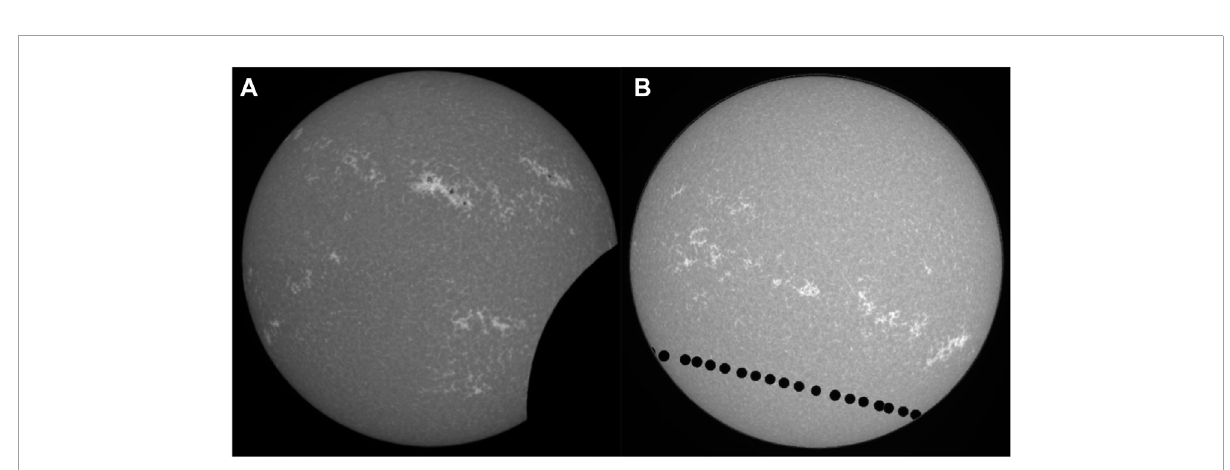
FIGURE 4 Examples of the solar observations obtained with the Rome/PSPT at the Ca II K line during the partial solar eclipse on 11th August 1999 (A) and transit of Venus on the solar disk on 8th June 2004 (B) . The latter image is a composite, which was produced post-facto by stitching together the best observations of the Sun during Venus’